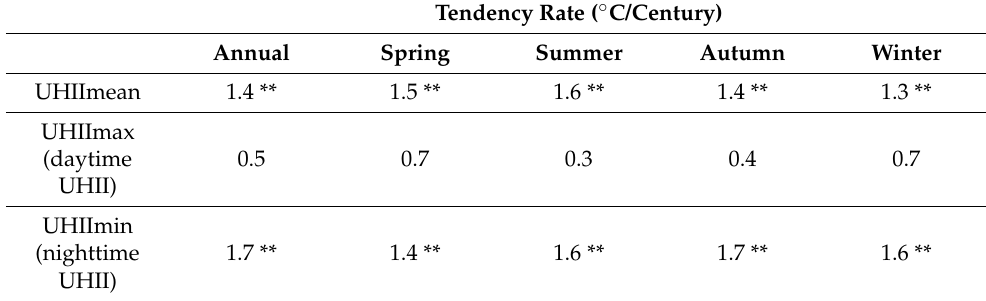
Table 3. The tendency rate and statistically significant of UHII mean , UHII max and UHII min during the period of